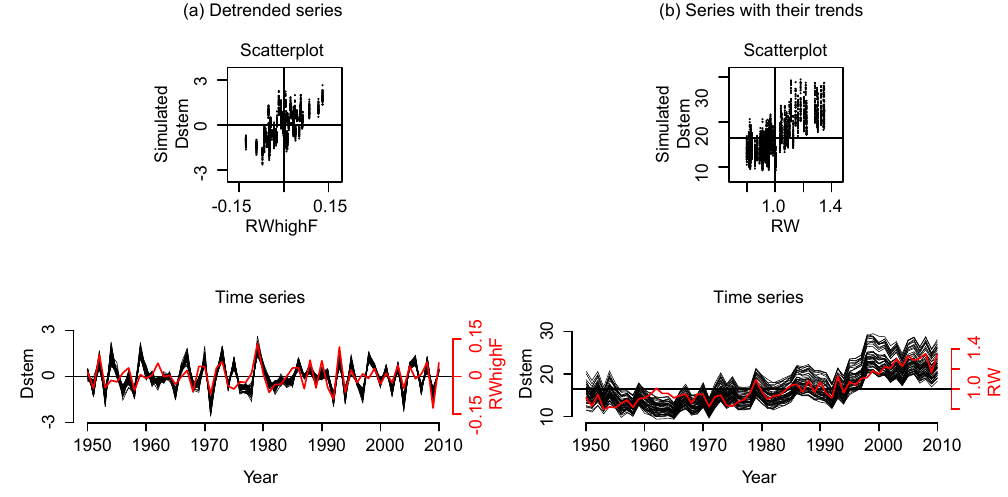
Figure 5. Comparison between the observed mean series of black spruce ring growth (unitless growth indexes) and MAIDEN-simulated carbon allocation to the stem (Dstem; gCm − 2 yr − 1 ) . (a) Detrended series (in the scatterplot the R 2 computed on data transformed to z scores is 0.24; r = 0 . 62, df = 59, p < 0.001). (b) Series with their trends (in the scatterplot the R 2 is 0.73; r = 0 . 86, df = 59, p < 0.001). In all plots, observations are compared with the values from all iterations retained by the MCMC